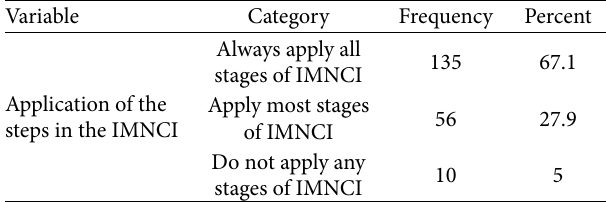
Table 7: Application of the steps in the case management protocol.